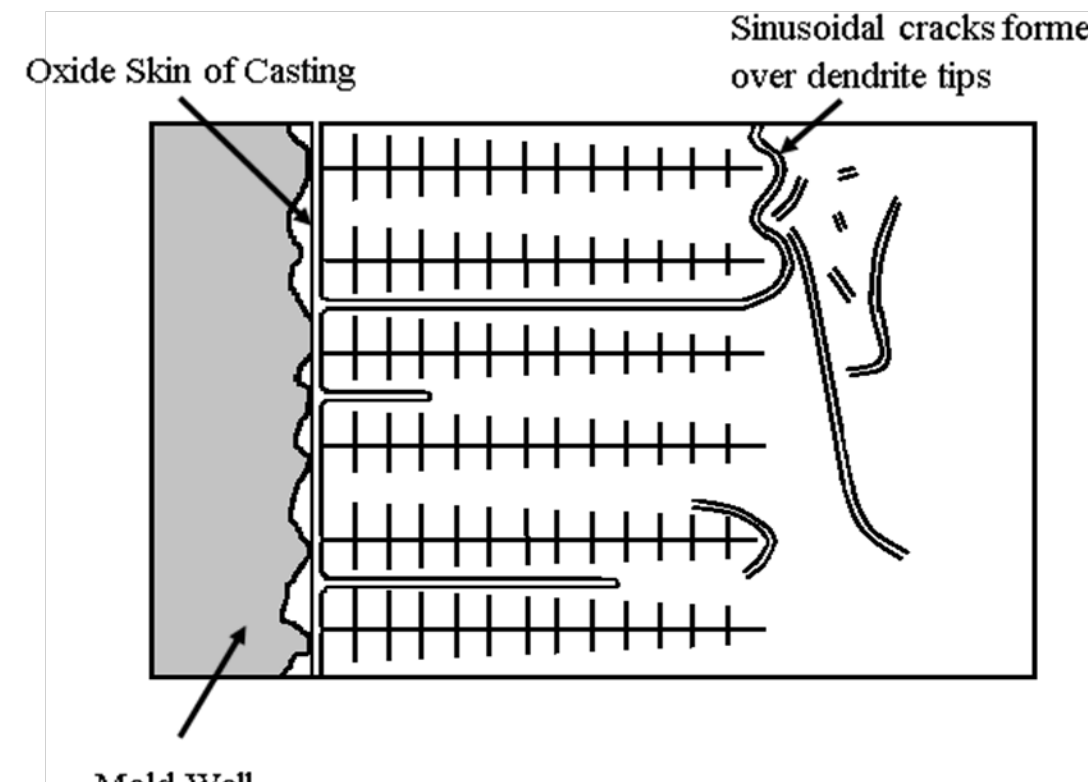
Figure 3. Bifilm cracks, floating randomly in the liquid metal, can be straightened (flattened) by dendritic growth, resulting in parallel cracks and sinusoidal cracks (the latter often being intergranular cracks). Metals 2022 , 12 , x FOR PEER REVIEW